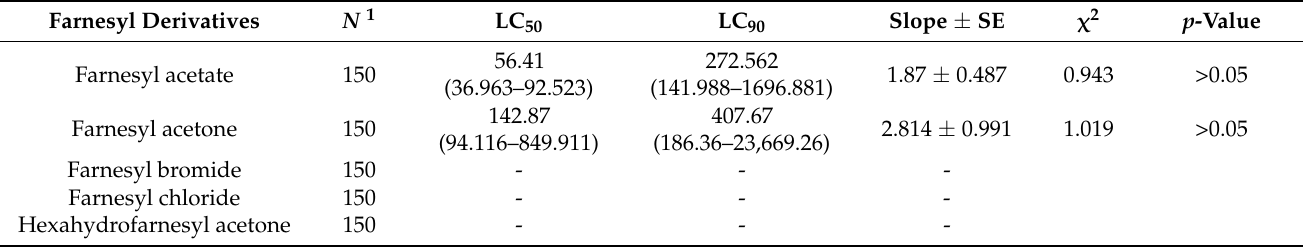
Table 2. Toxicity of farnesyl derivatives on the second instar larvae of P. xylostella. LC 50 , sublethal